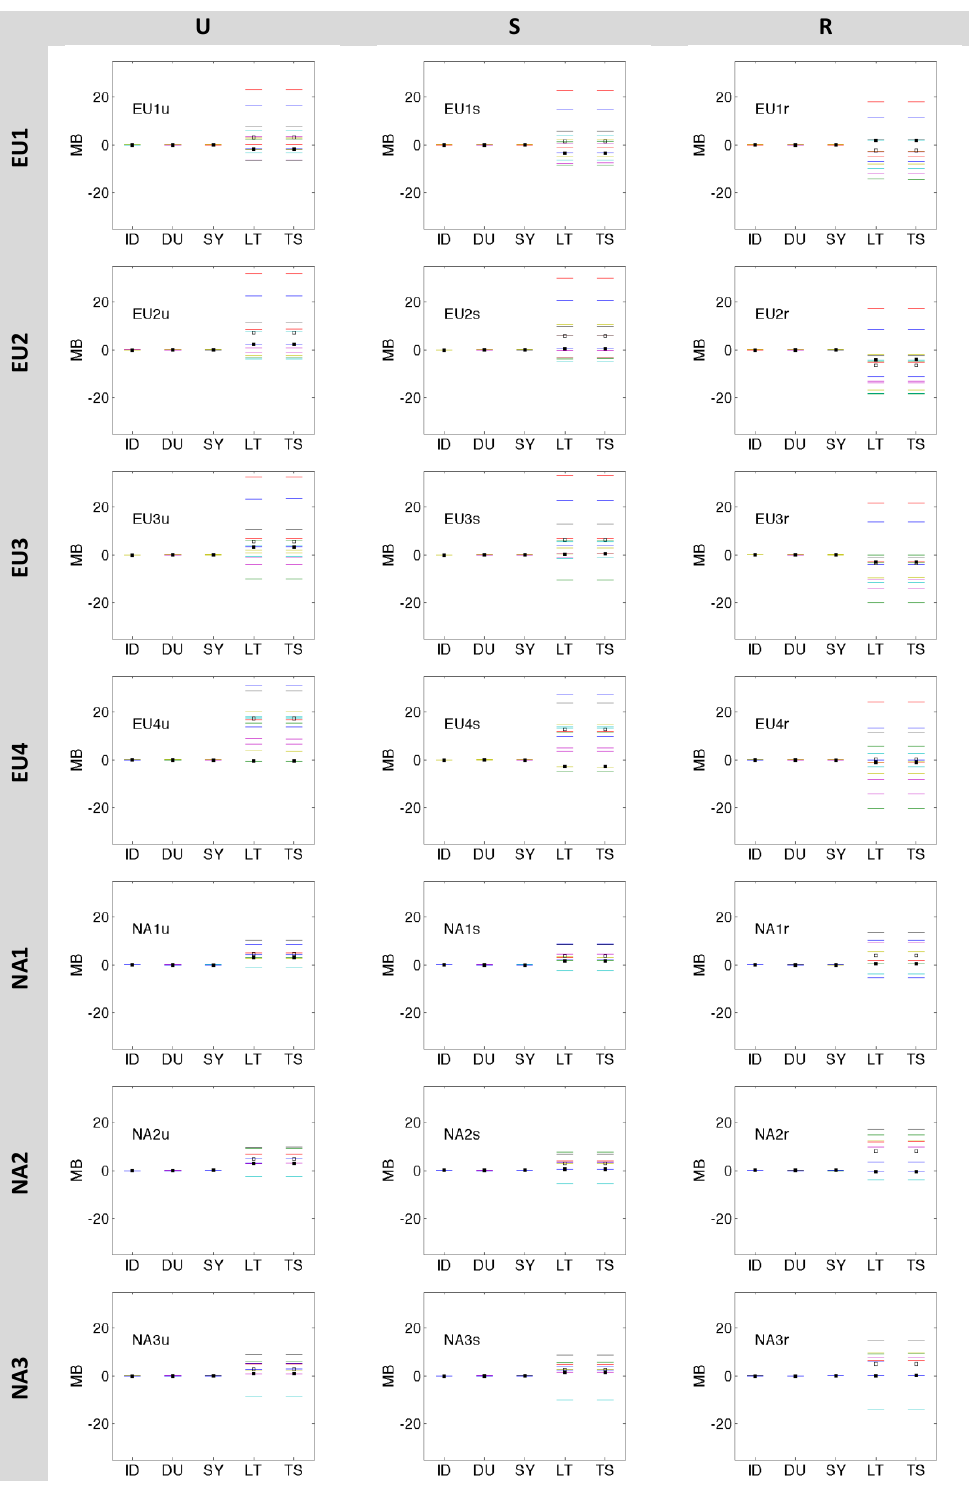
Fig. 7e. Properties of the spectrally decomposed modelled time-series of ozone, into four (ID, DU, SY, LT) components, versus their observed counterparts. Results are shown for all seven subdomains and three ozone aggregation types. For all plots, the square marker reflects the mm, the filled square the kz, the red circle the observations and the coloured lines the individual models. (e) MB: decomposition of the mean bias error of the modelled time-series. For all models, the bias error equals the LT component bias. In comparison to mm, kz simulations have lower absolute